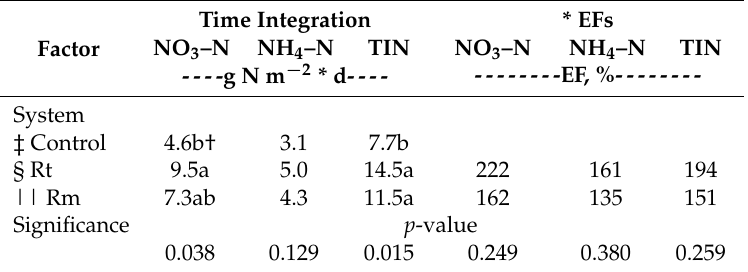
Table 2. Treatment means and significance of soil N pools post residue management prior to row establishment.